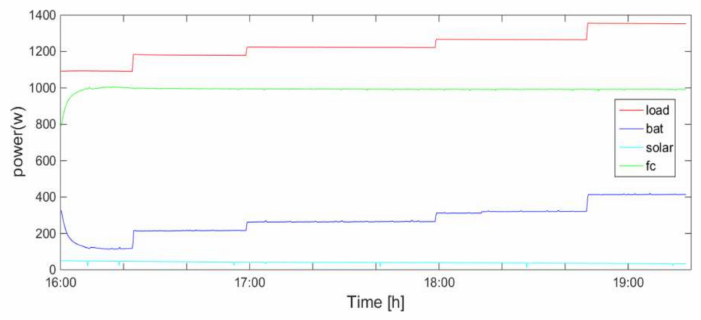
Figure 21. Power curves in scenario 7 (with the fuel